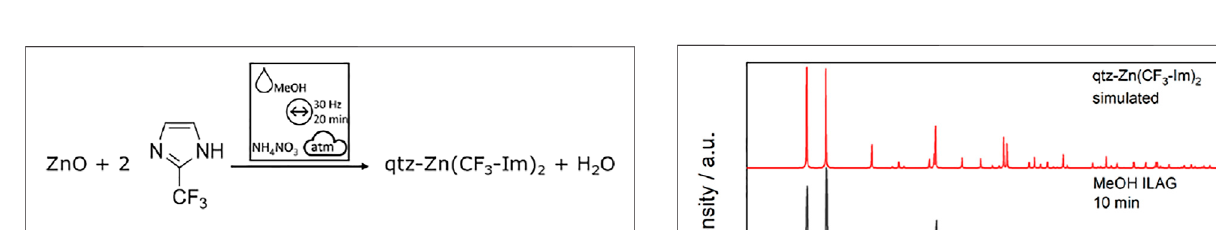
Scheme 2 | ILAG of ZnO with H-CF 3 -Im, leading to the dense qtz polymorph of Zn(CF 3 -Im) 2 .